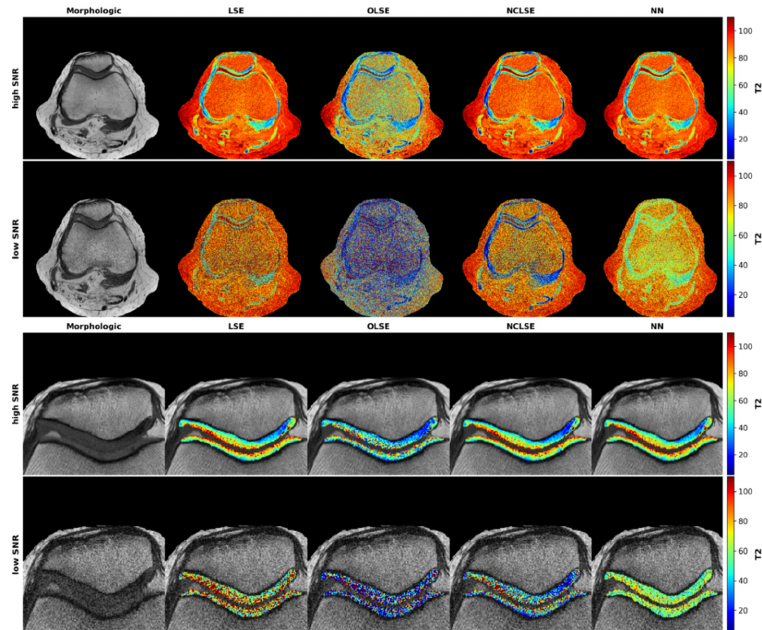
Figure A2. Representative T2 maps as a function of signal-to-noise ratio (SNR) and underlying fitting method. Visualization of the axial plane acquired at high SNR (first row) and at low SNR (second row) of the entire joint that was cropped and zoomed to the patellofemoral compartment (third and fourth rows for high- and low-SNR images) in this representative knee joint. The first column shows the T2-weighted morphologic images ( TE = 30 ms). The second to fifth columns visualize the T2 maps following fitting based on the Least-Squares Estimation (LSE, second column), Offset LSE (OLSE, third column), Noise-Corrected LSE (NCLSE, fourth column), and the Neural Network (NN, fifth column). T2 relaxation times [ms] are color-coded as indicated by the scale bars on the right (range: 0–110